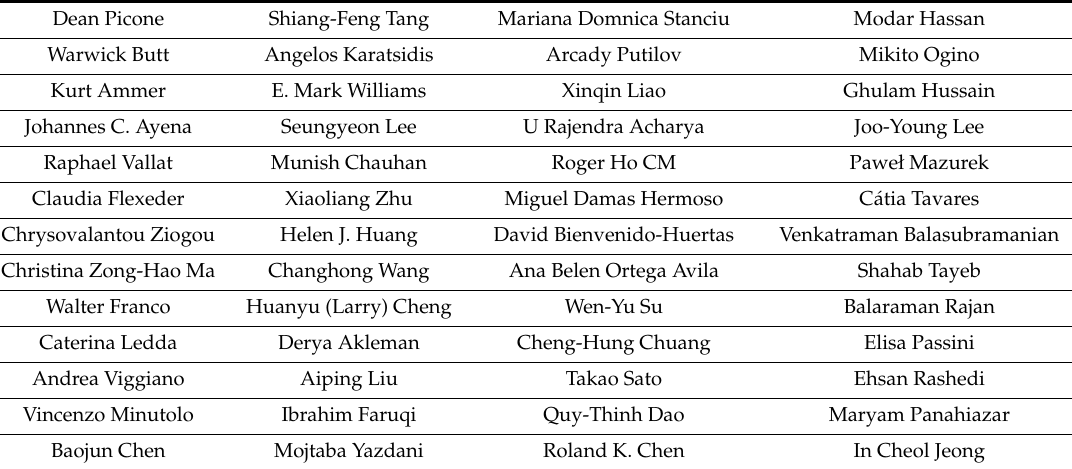
Table A1. Special Issue (SI) reviewer